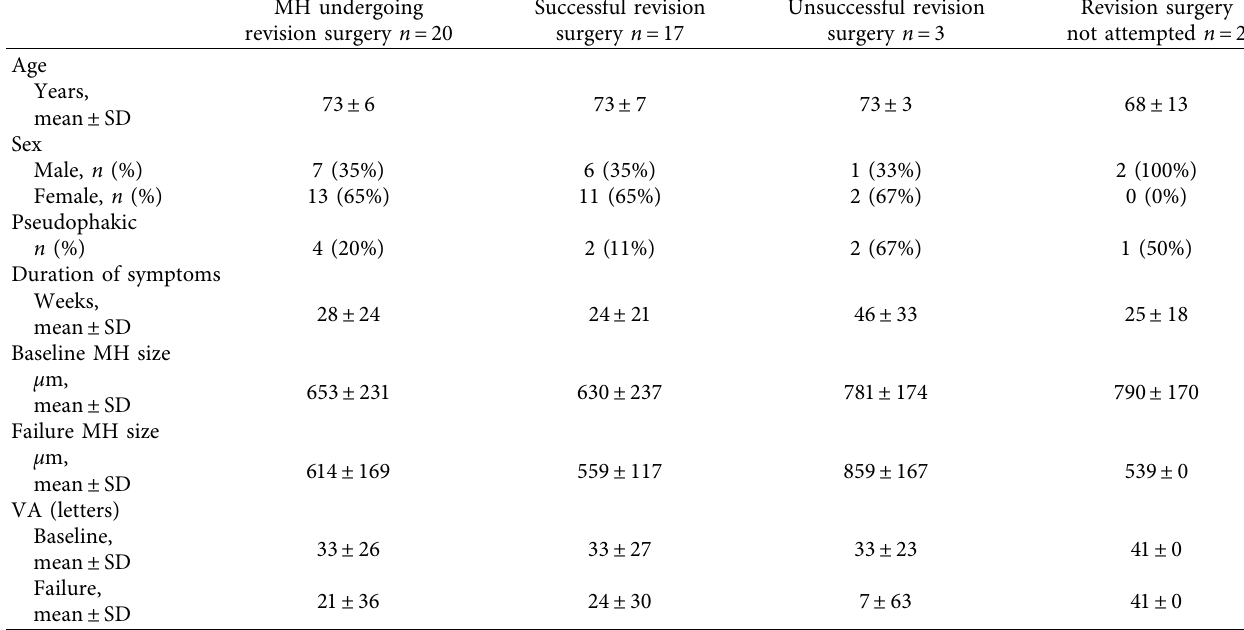
Table 1: Clinical and demographic characteristics upon the first presentation.